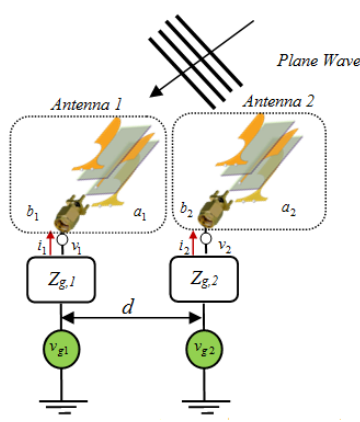
FIGURE 3. Coupling in receiving mode